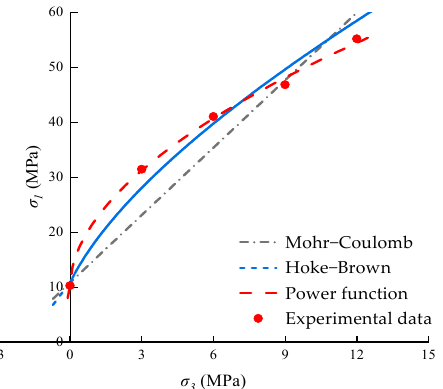
Figure 6. Fitting results of peak strength under different strength criteria.